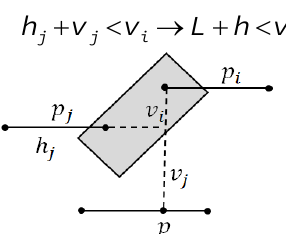
Figure 8. Definition of